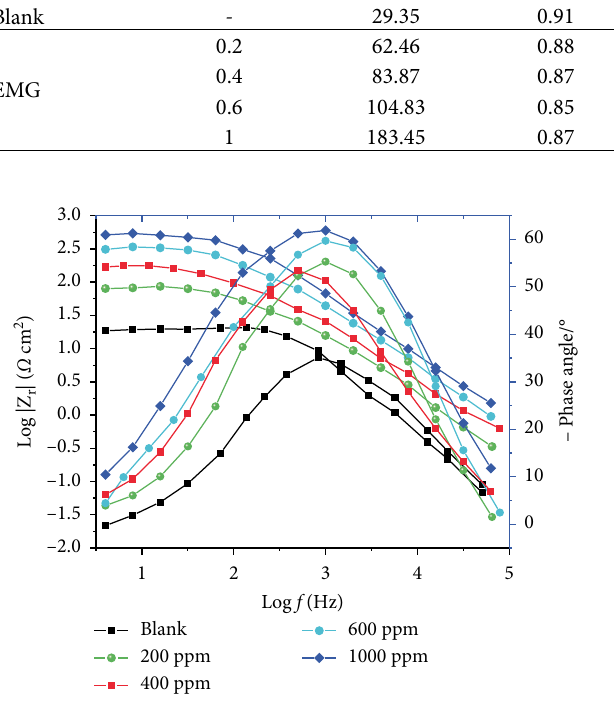
Figure 8: Bode [log (Freq/Hz) vs. log ( │ Zr │ /ohm.cm2)] and phase angle [log (Freq/Hz) vs.–Phase/deg] plots of impendence spectra for mild steel in 1 M HCl in presence and absence of EMG compound at 303 K.